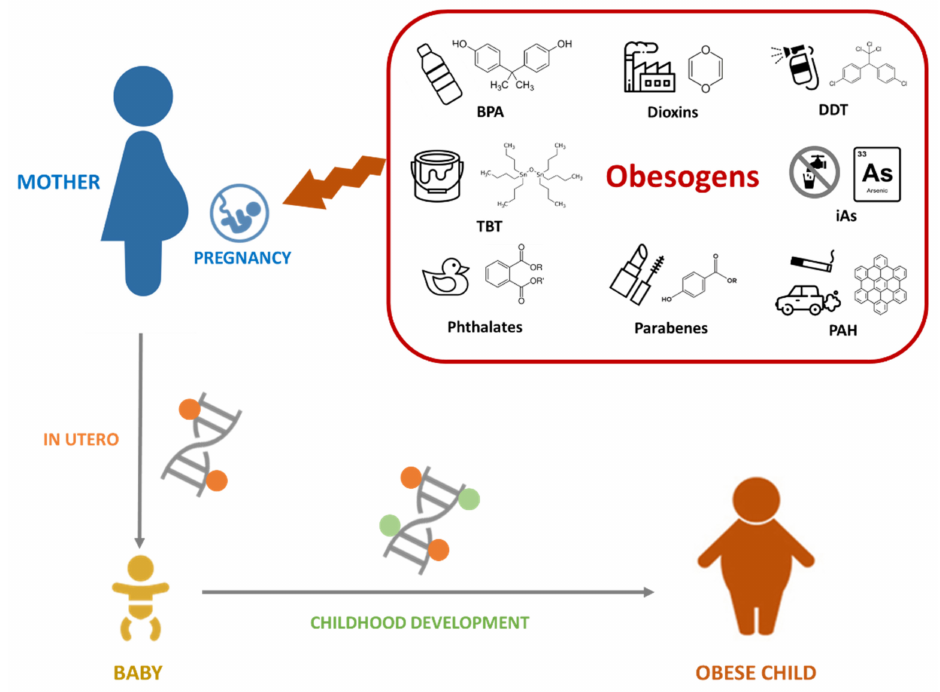
Figure 2. Schematic effect of obesogens on epigenetic hallmarks leading to childhood obesity. Several environmental pollutants may alter the inherited epigenetic profiles during pregnancy, which would contribute to the later development of childhood obesity and other metabolic related diseases. BPA, bisphenol A; DDT, dichlorodiphenyltrichloroethane; iAs, inorganic arsenic; PAH, polycyclic aromatic hydrocarbons; and TBT,